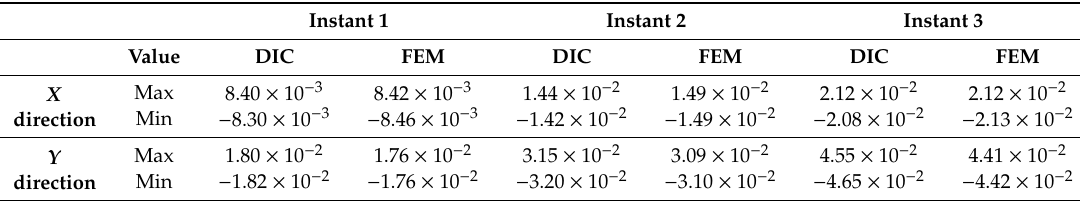
Table 6. Maximum and minimum displacement values for geometry B.